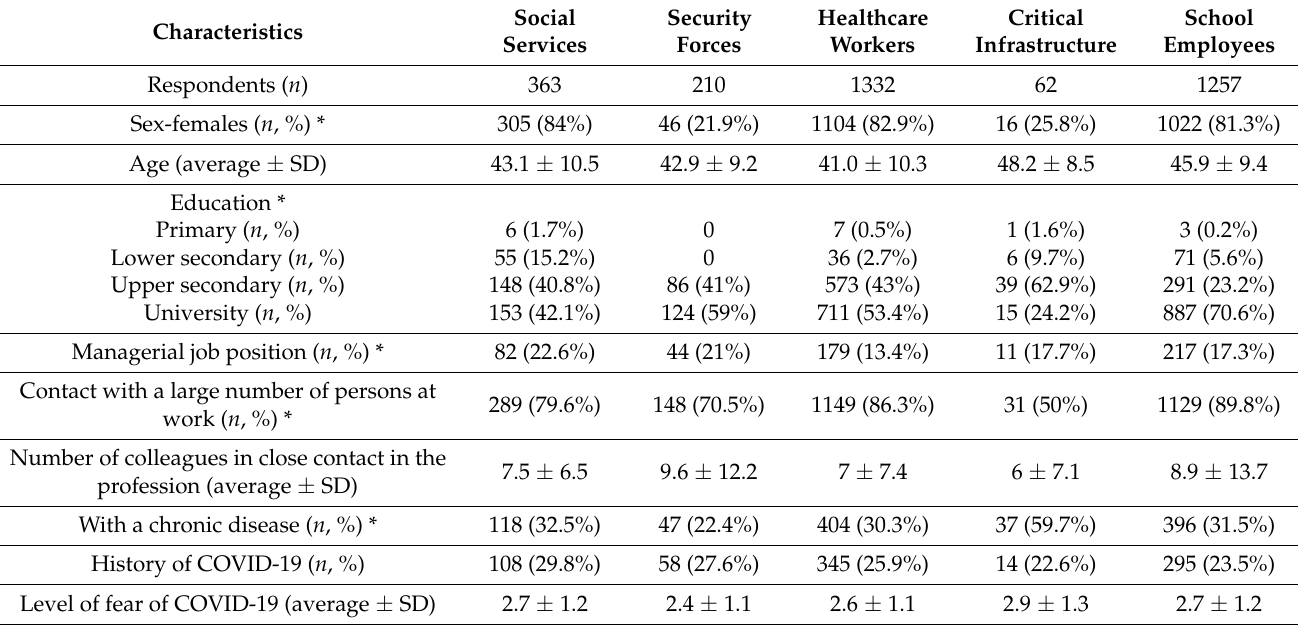
Table 1. Occupational groups’